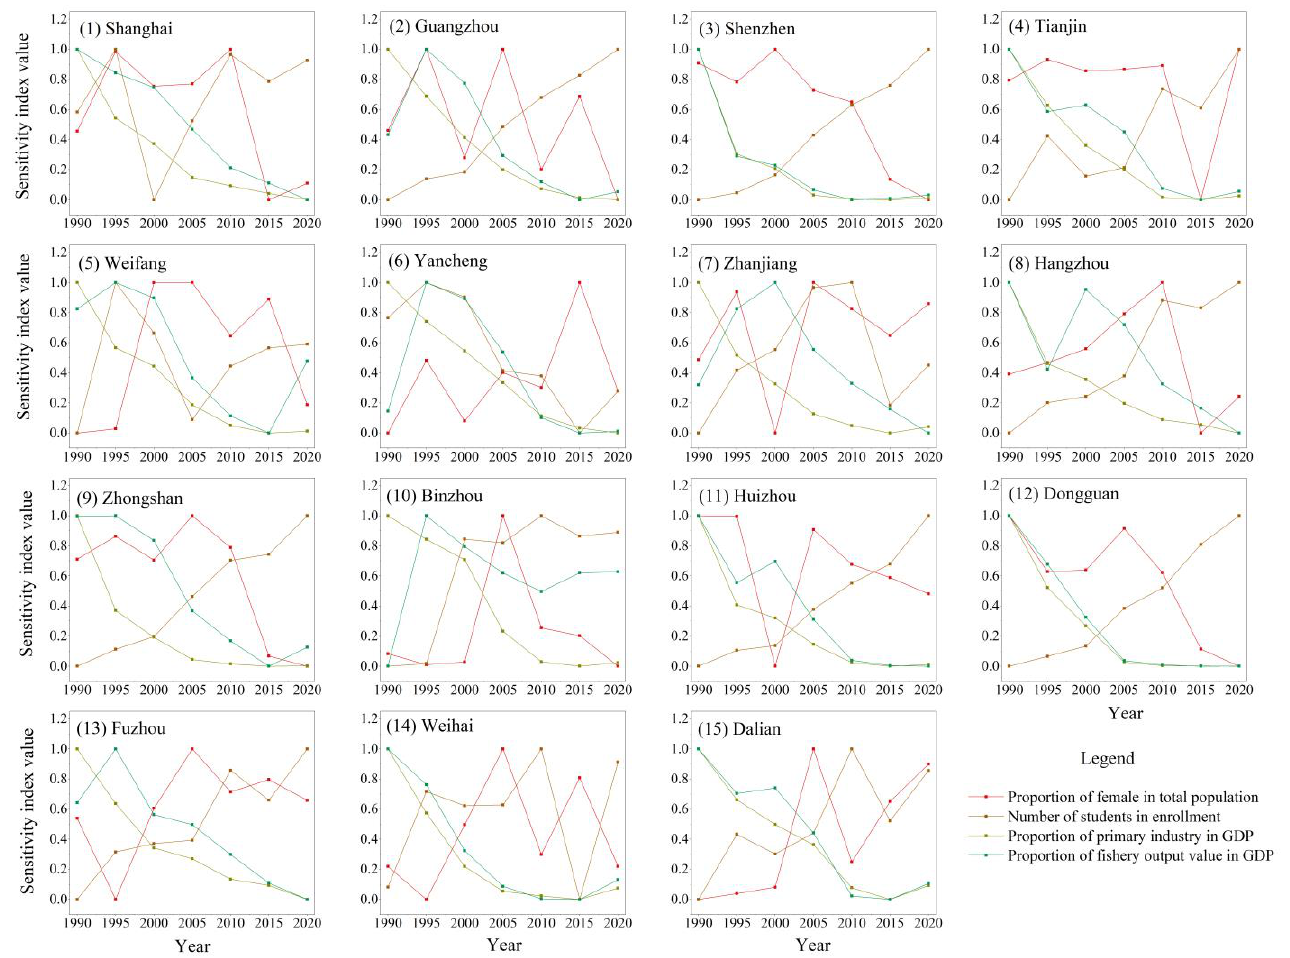
Figure 5. Trend chart of sensitivity index values after positive standardization in 15 coastal cities of China from 1990 to 2020.